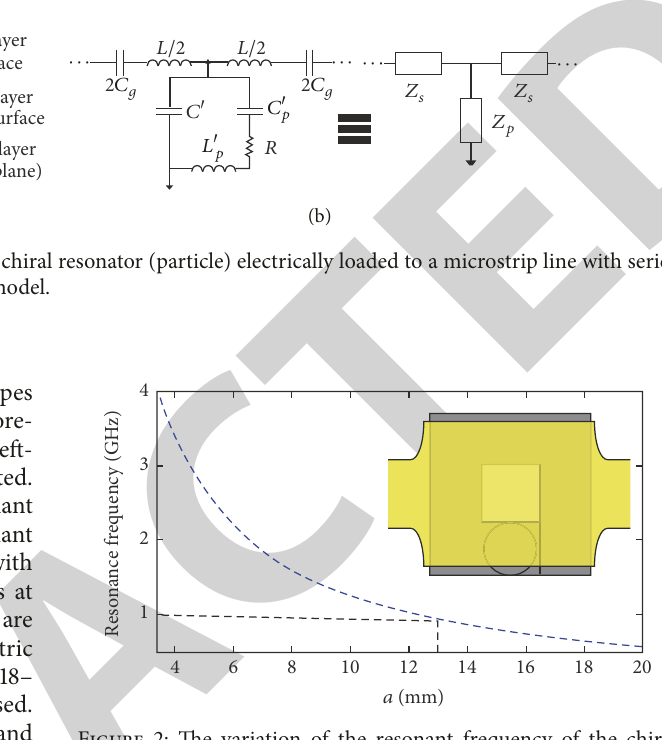
Figure 2: The variation of the resonant frequency of the chiral particle with respect to changing “ 𝑎 ” (depicted in Figure 1). Other dimension parameters are set to 𝑤 ≈ 𝑎/3 , 𝑊 𝑠 = 5.5 mm, 𝐶 𝑙 = 10mm, 𝐶 𝐶 𝑤 = 11.4mm, and 𝑑 = 1.4